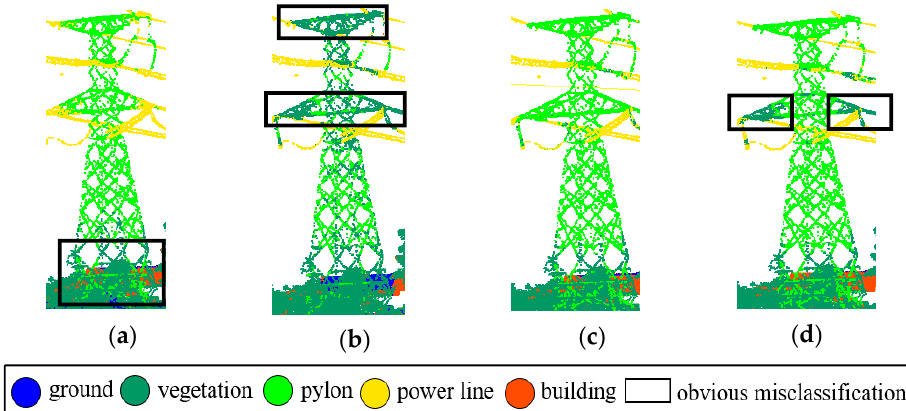
Figure 10. The classification results of pylon type-I with different classifiers (feature set = F 0 , class distribution = unbalanced, R = 1.5 m): ( a ) The pylon is colored by the KNN prediction results; ( b ) the pylon is colored by the LR prediction results; ( c ) the pylon is colored by the RF prediction results; ( d ) the pylon is colored by the GBDT prediction results.